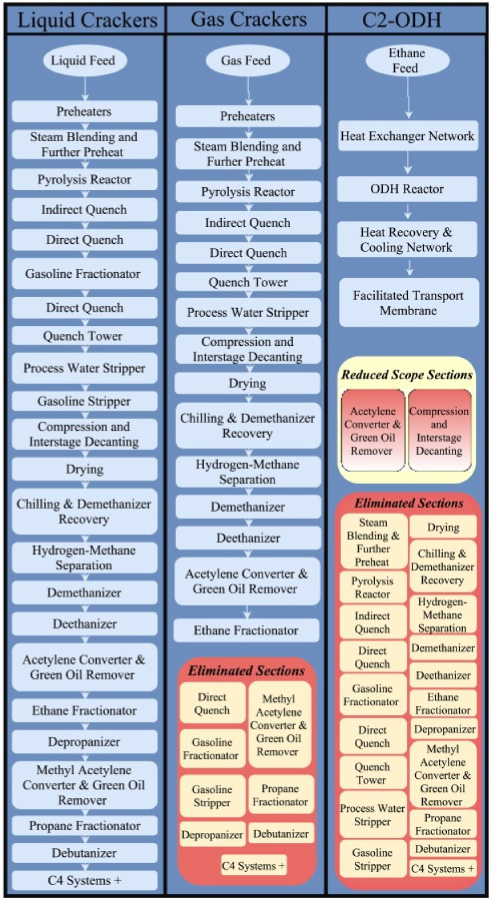
Figure 1. Scheme of conventional steam cracking vs. ODH unit operations. Adapted from ref. [1], Copyright (2017), with permission from